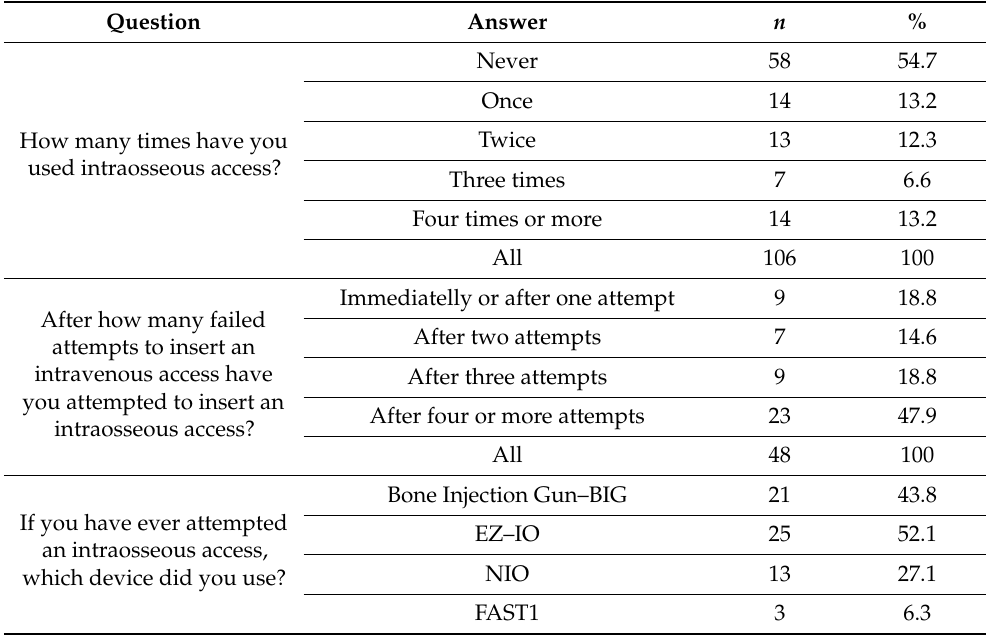
Table 2. Questions regarding previous experience with intraosseous